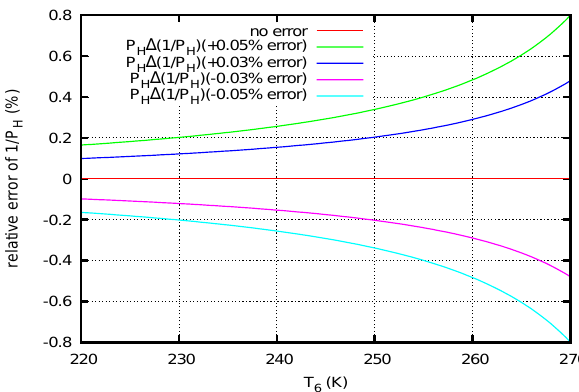
Fig. 1. Residuals T 6 / 2 − ˆ T 6 / 2 (blue curve) and T 6 / 2 − T 6 / 4 (red curve) averaged over the indicated latitude band and for each day of NOAA-12 operation.